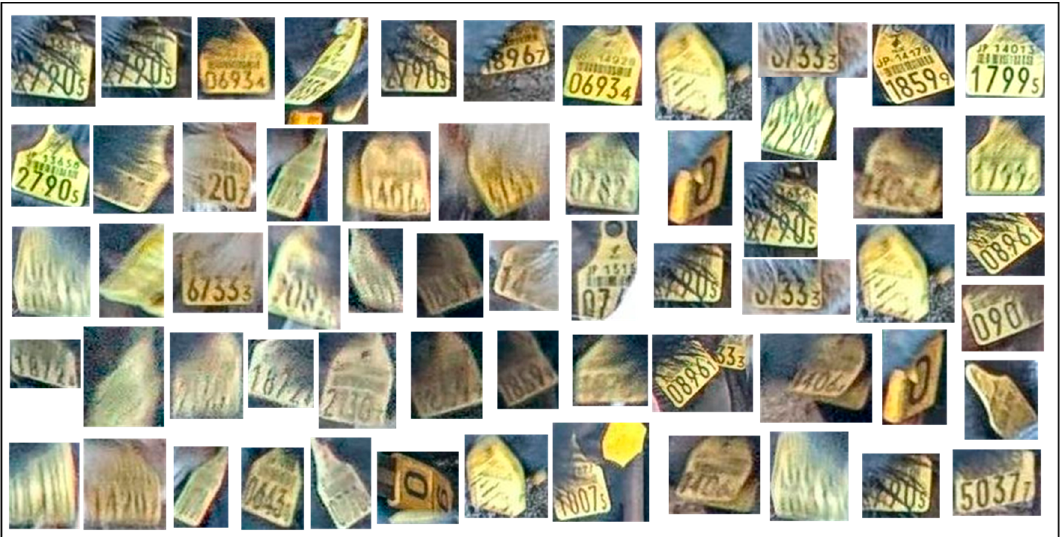
Figure 5. Sample ear tag images after ear tag extraction.